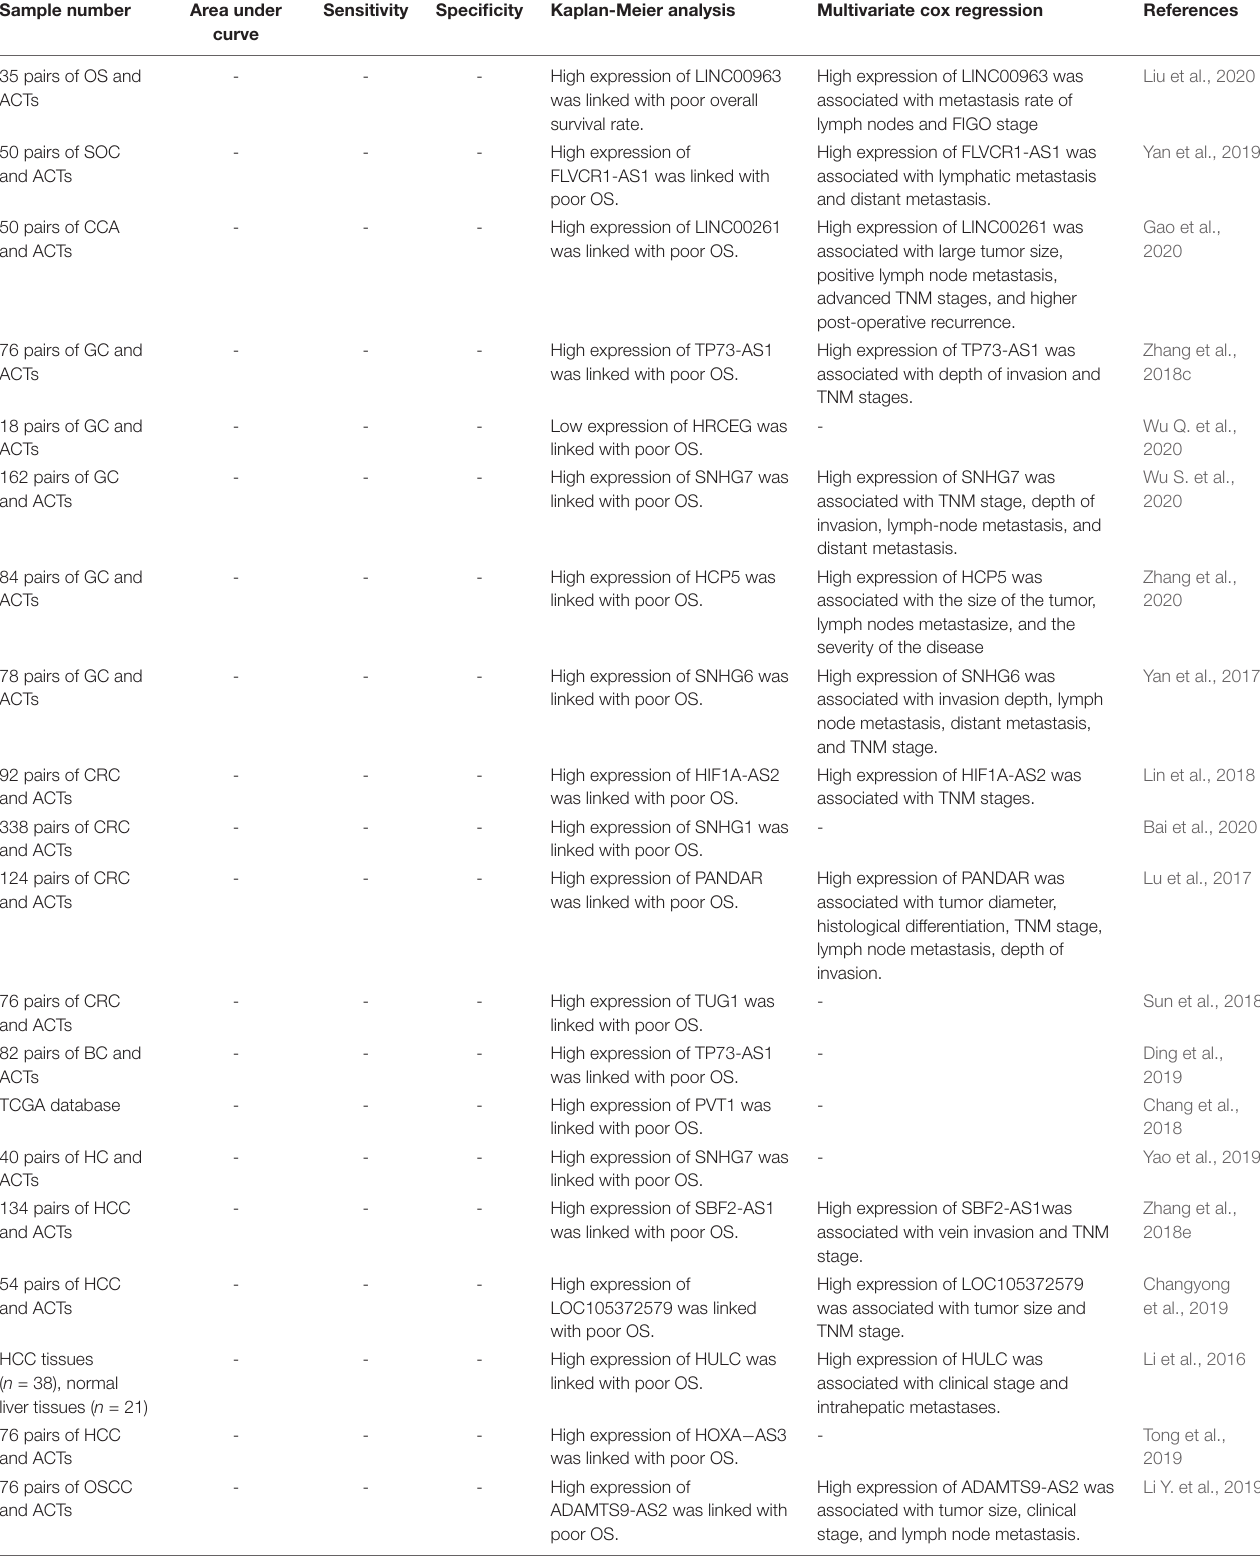
TABLE 2 | Diagnostic and prognostic role of EMT-associated lncRNAs in cancer (ACTs: adjacent control tissues, OS: overall survival). Sample